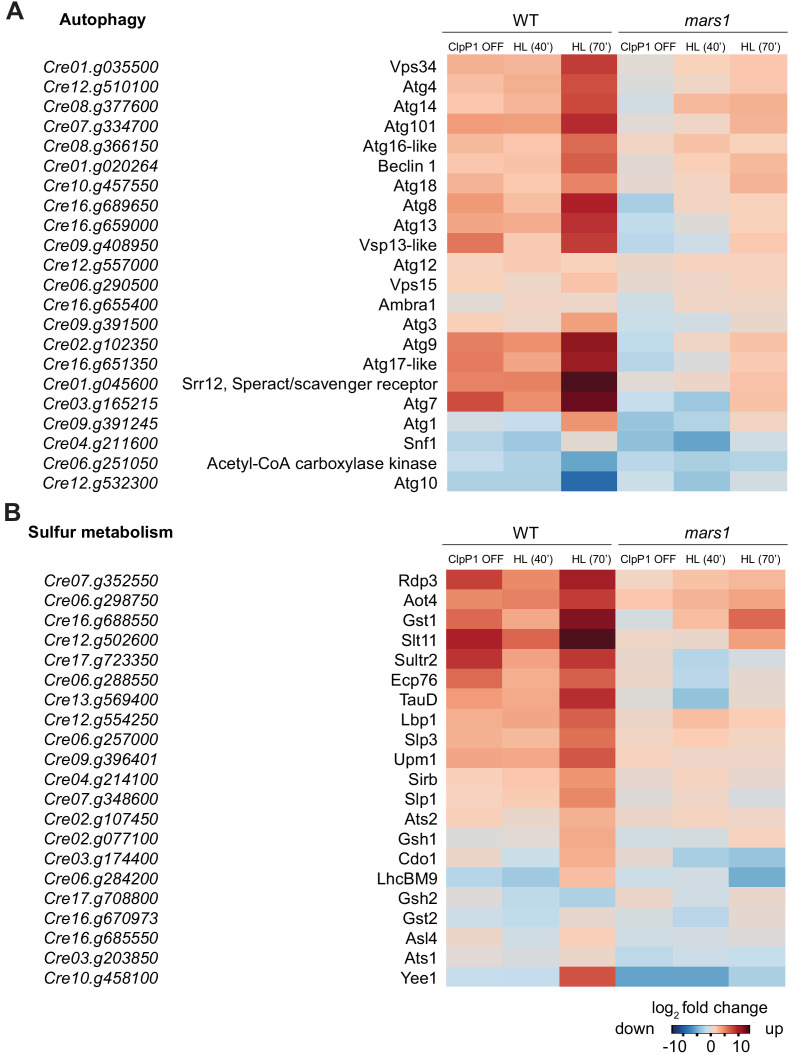
mars1 cells do not activate autophagy and sulfur starvation genes during cpUPR inducing conditions.(A) Heatmap comparing expression pattern of manually-selected genes involved autophagy in WT and mars1-1 mutant upon HL exposure (40 and 70 min) and ClpP1 repression. MARS1 disruption impairs the induction of a small subset of autophagy genes. HL = high light; ClpP1 OFF = ClpP1 repression. (B) Heatmap comparing expression pattern of manually-selected genes involved sulfur assimilation and metabolism in WT and mars1-1 mutant upon high light exposure (40 and 70 min) and ClpP1 repression. Surprisingly, both chloroplast stresses induce many of these genes and MARS1 disruption impairs induction of a subset of them. HL = high light; ClpP1 OFF = ClpP1 repression.